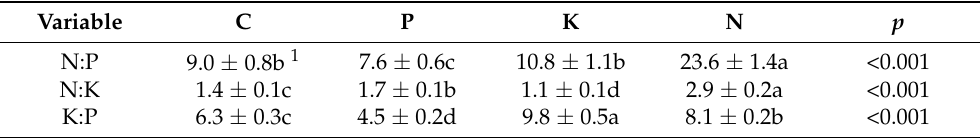
Table 5. The influence of N, P, or K fertilization on stoichiometry of nutrients for Serianthes leaves. Mean of Serianthes grandiflora and Serianthes nelsonii . C = control; P = phosphorus fertilization; K = potassium fertilization; N = nitrogen fertilization. Mean ± SE, n =